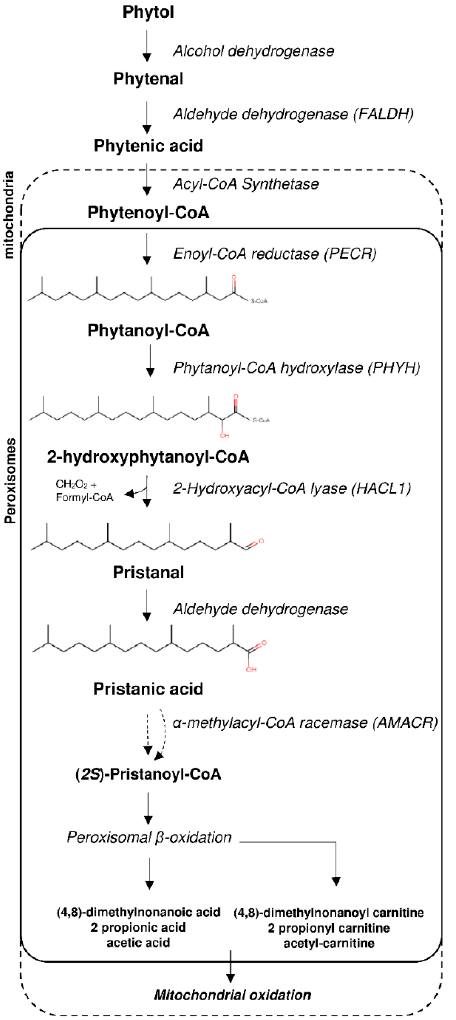
Figure 1. Phytol degradation pathway via peroxisomal alpha-oxidation.